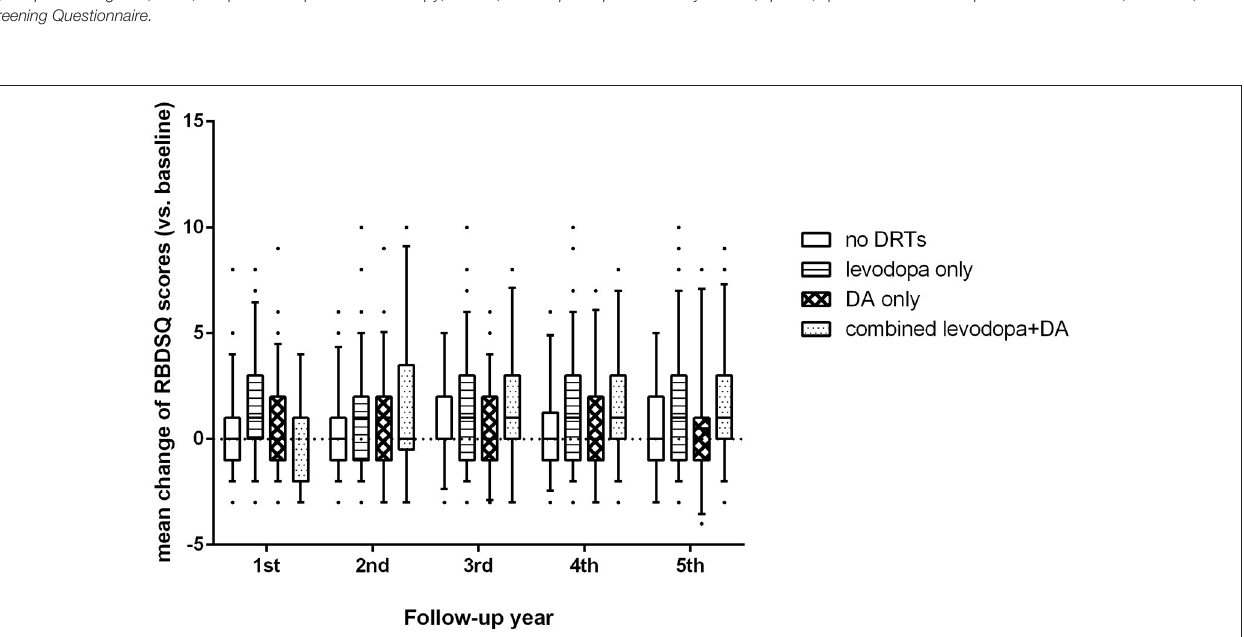
FIGURE 1 | Changes of RBDSQ scores among patients on different